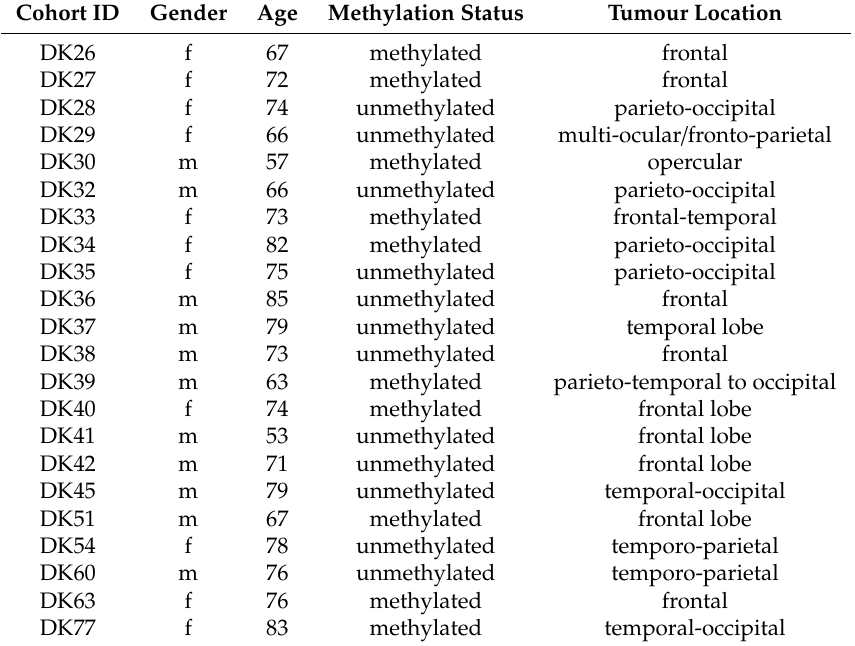
temporal-occipital